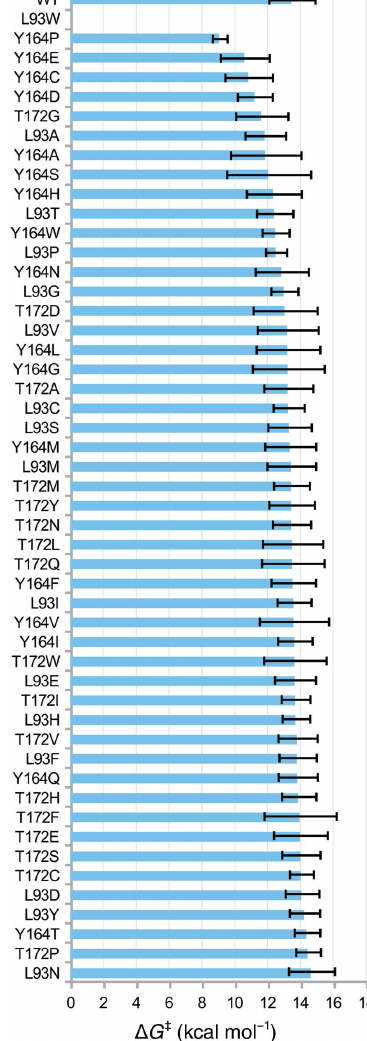
Figure 9 Results of the separate single-site saturation mutagenesis experiments at positions 93, 164 and 172. Activation energies ( (cid:2) G ‡ ) are given as mean values, with error bars showing the standard deviation over 24 individual EVB simulations. The corresponding raw data are provided in Supplementary Table